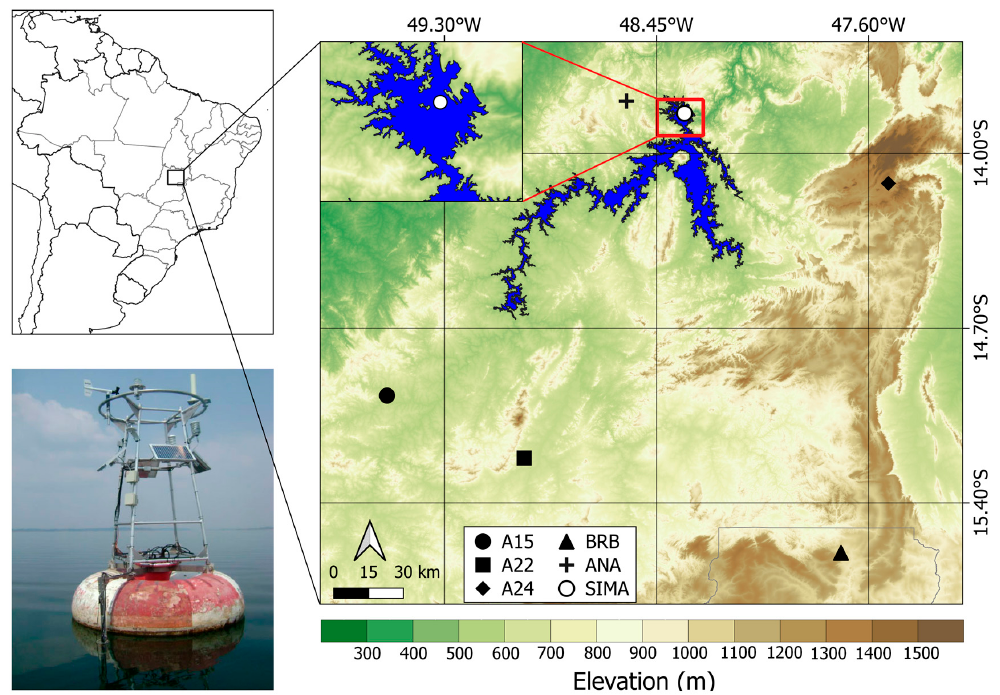
Figure 1. The geographical location of the Serra da Mesa water reservoir in the Central region of Brazil the lake geography, the locations of the ground stations and a picture of SIMA autonomous data collection buoy system in operation in the northern area of the lake.